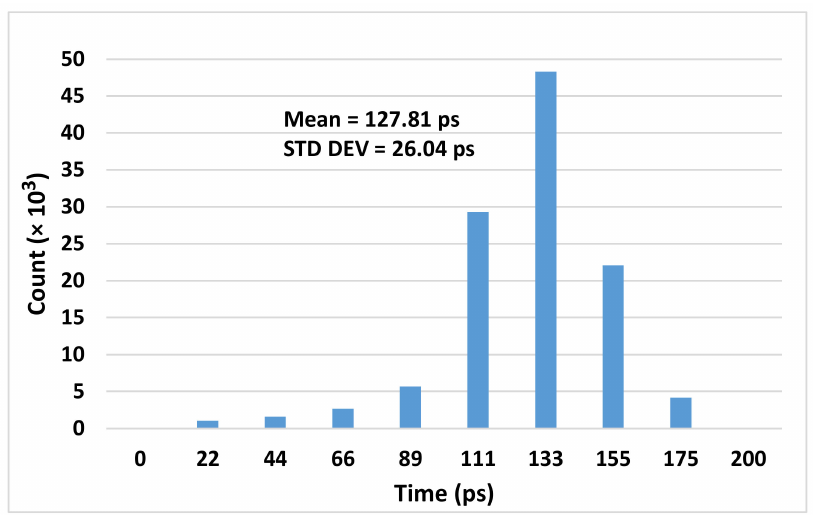
Figure 10. Measurement histogram of a constant time interval.